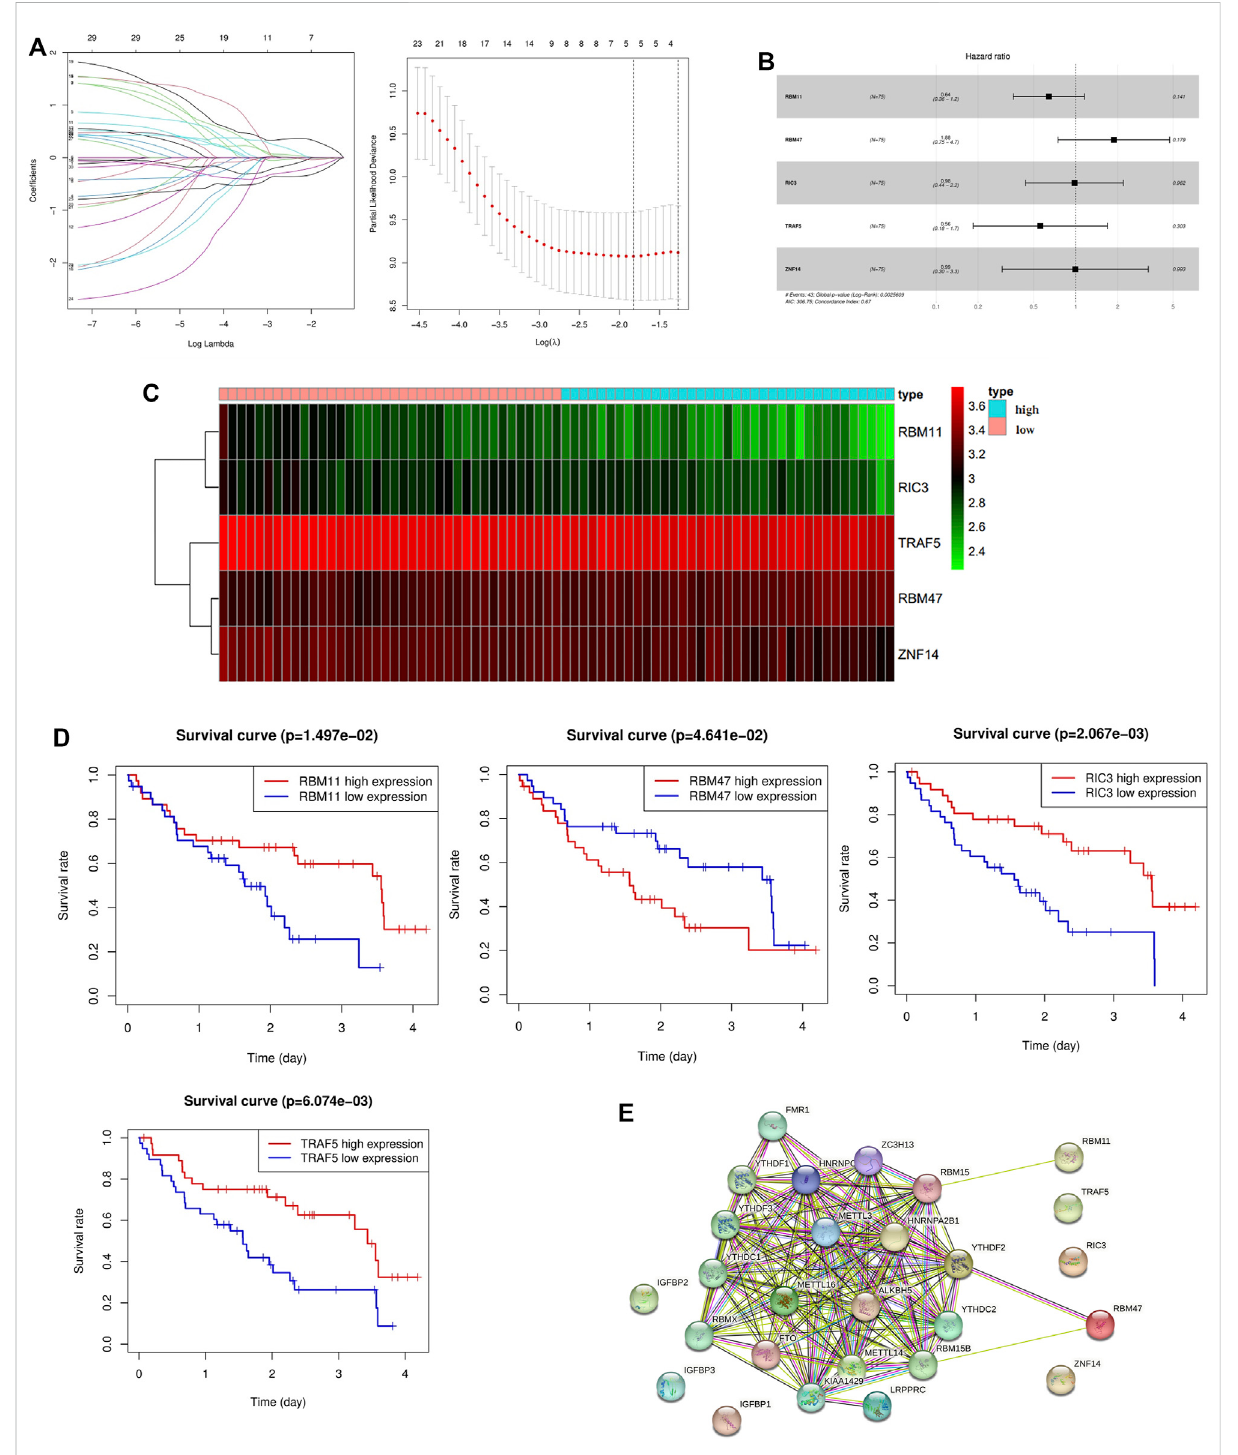
FIGURE 4 Screening of key genes associated with IPF prognosis. (A) LASSO regression analysis screened 5 genes associated with prognosis; (B) Multivariate Cox regression analysis of the effect of fi ve key genes RBM11, RBM47, RIC3, TRAF5, ZNF14 on the prognosis of patients with IPF; (C) Expression levels of key candidate genes in different IPF samples; (D) Kaplan-Meier survival analysis of key genes; (E) Protein interactions between fi ve key genes and 23 m6A